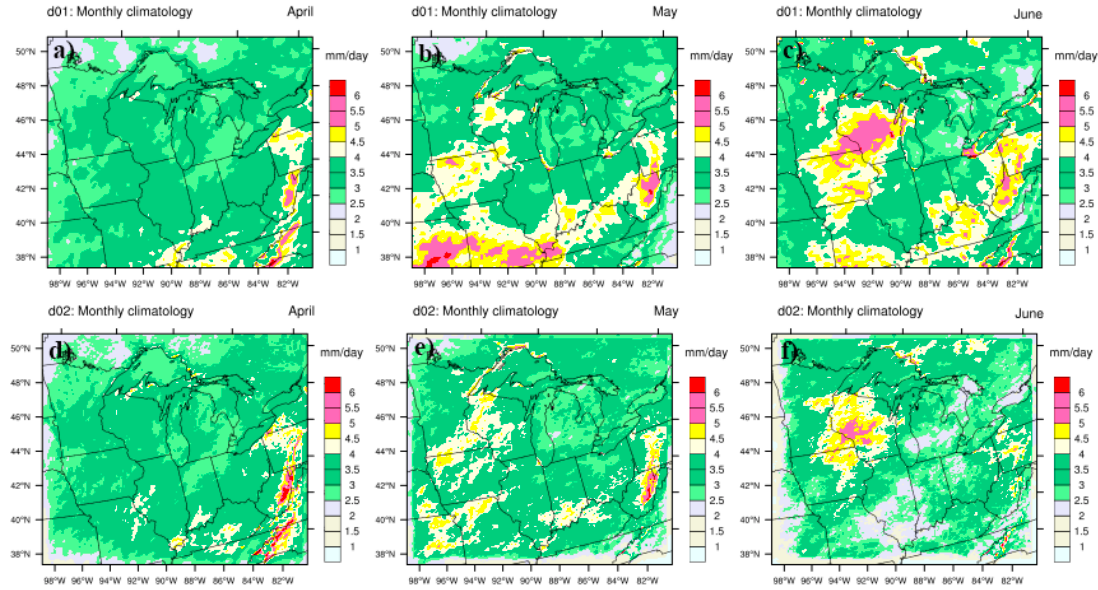
Figure 6. Top panel shows the monthly climatological precipitation for WRF model domain at 12-km with explicitly resolve convective precipitation for ( a ) April, ( b ) May, and (June). Bottom panel ( d ), ( e ) and ( f ) are same as top panel ( a ), ( b ) and ( c ) respectively but for domain at 4-km without explicit resolved convection.